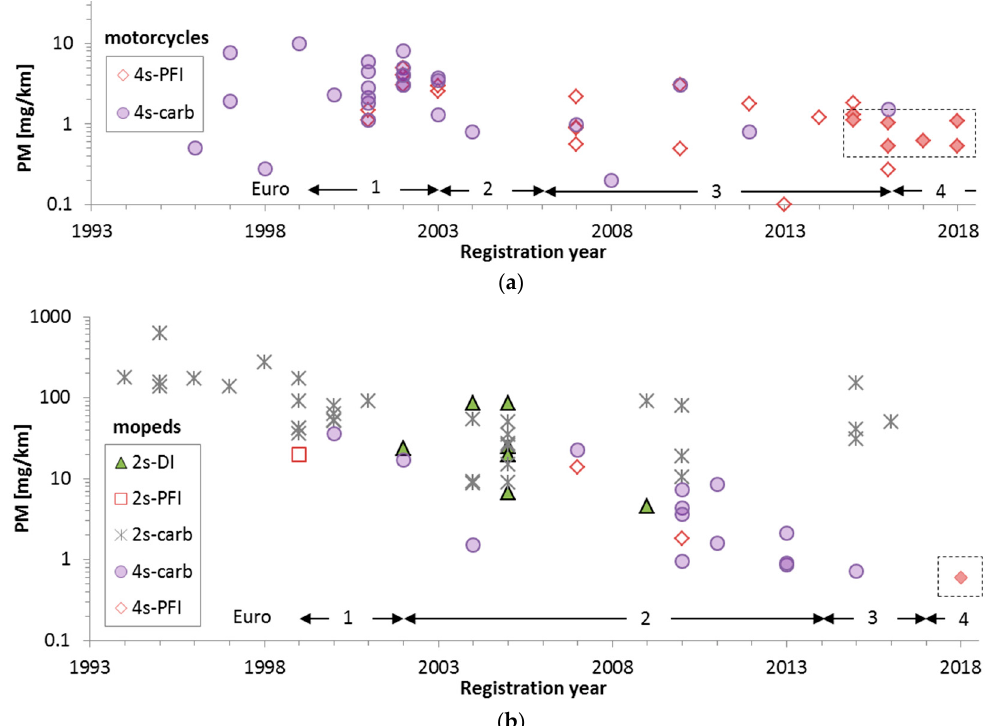
Figure 5. Particulate matter (PM) mass emissions from the literature (details in text) for ( a ) motorcycles and ( b ) mopeds with 2-stroke (2s) or 4-stroke (4s) engines with carburettor (carb), direct injection (DI) or port fuel injection (PFI). The vehicles of this study are in dotted boxes.